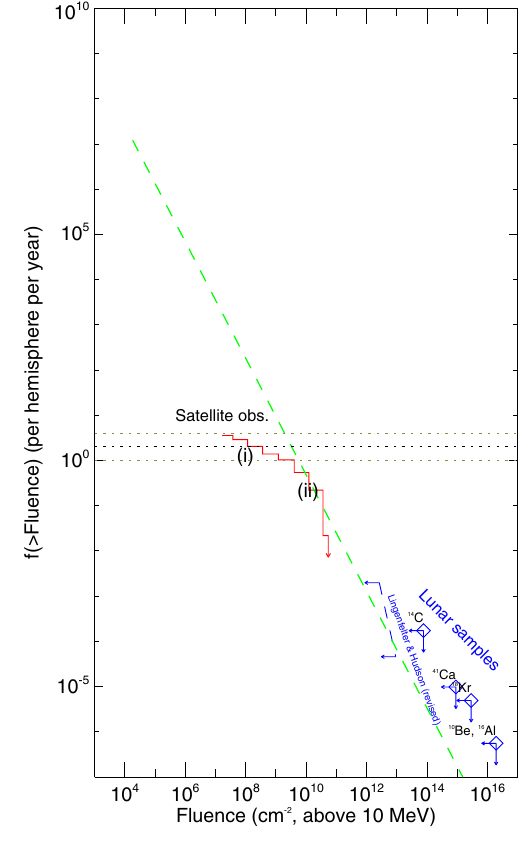
Fig. 29 Cumulative frequency distribution of SEP events with fluences greater than F 10 (for particles with energies above 10 MeV). Red histogram: satellite-based direct observations; Blue diamonds: conservative upper limits derived from lunar isotopes (see Sect. 5.2); Blue dashed line: upper limit based on 14 C record (Hudson 2010); Image reproduced by permission from Schrijver et al. (2012), copyright by